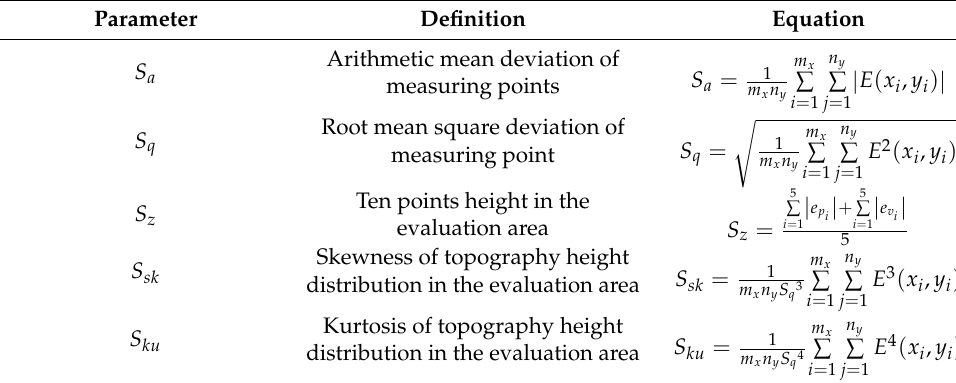
Table 1. Three-dimensional amplitude parameters.